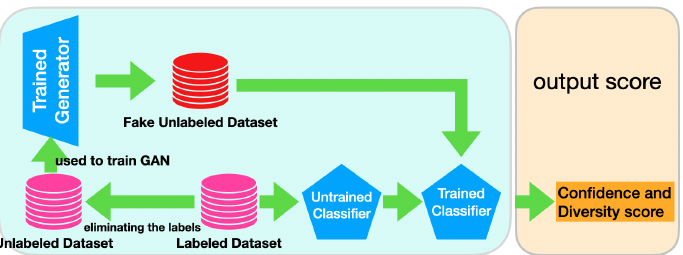
Figure 6. The architecture of an oracle instance based on Confidence and Diversity